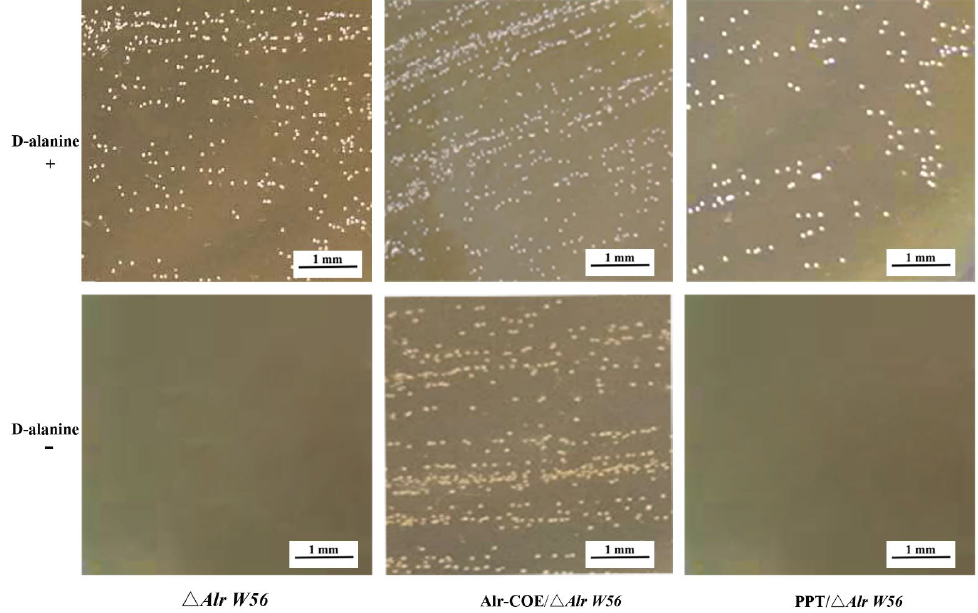
Figure 2. The D-alanine demand identification of recombinant L. casei strain pPG-Alr-COE/ ∆ Alr W56 . The recombinant strains pPG-Alr-COE/ ∆ Alr W56 , pPG-T7g10-PPT/ ∆ Alr W56 , and ∆ Alr W56 were streaked on de Man–Rogosa–Sharpe (MRS) plates to detect the demand of D-alanine. “+” and “ − ” represent MRS plates with and without D-alanine, respectively; Alr-COE/ ∆ Alr W56 , pPG-Alr-COE/ ∆ Alr W56 ; PPT/ ∆ Alr W56 , pPG-T7g10-PPT/ ∆ Alr W56 . The authors state that the scientific conclusions are unaffected. This correction